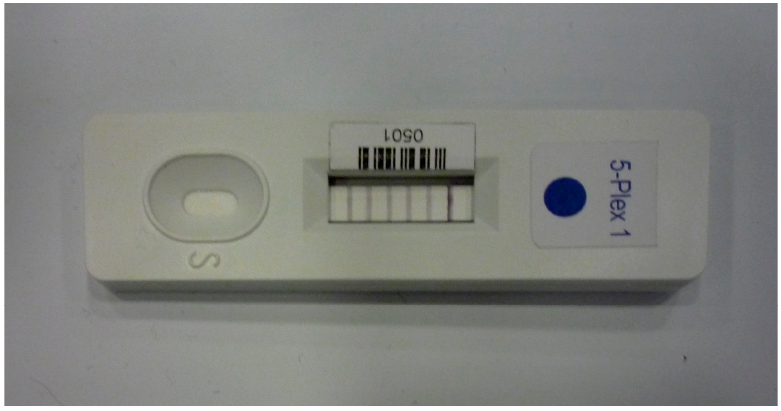
Figure 3. A commercial lateral fl ow test for contemporary assay of biological warfare agents.